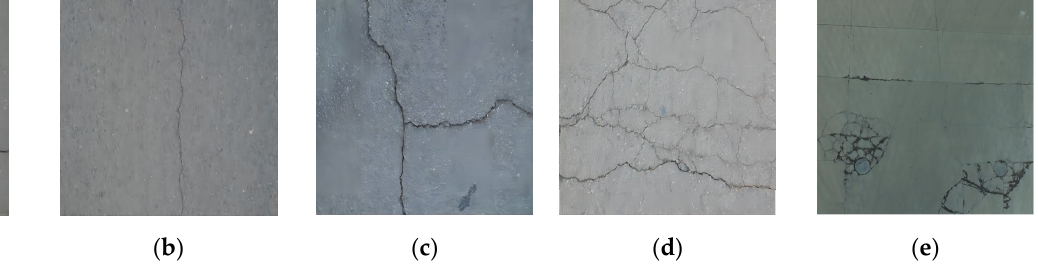
Figure 15. Schematic diagram of 5 types of concrete pavement distress. ( a ) Transverse crack. ( b ) Longitudinal crack. ( c ) Cross crack. ( d ) Alligator crack. ( e ) Pothole.